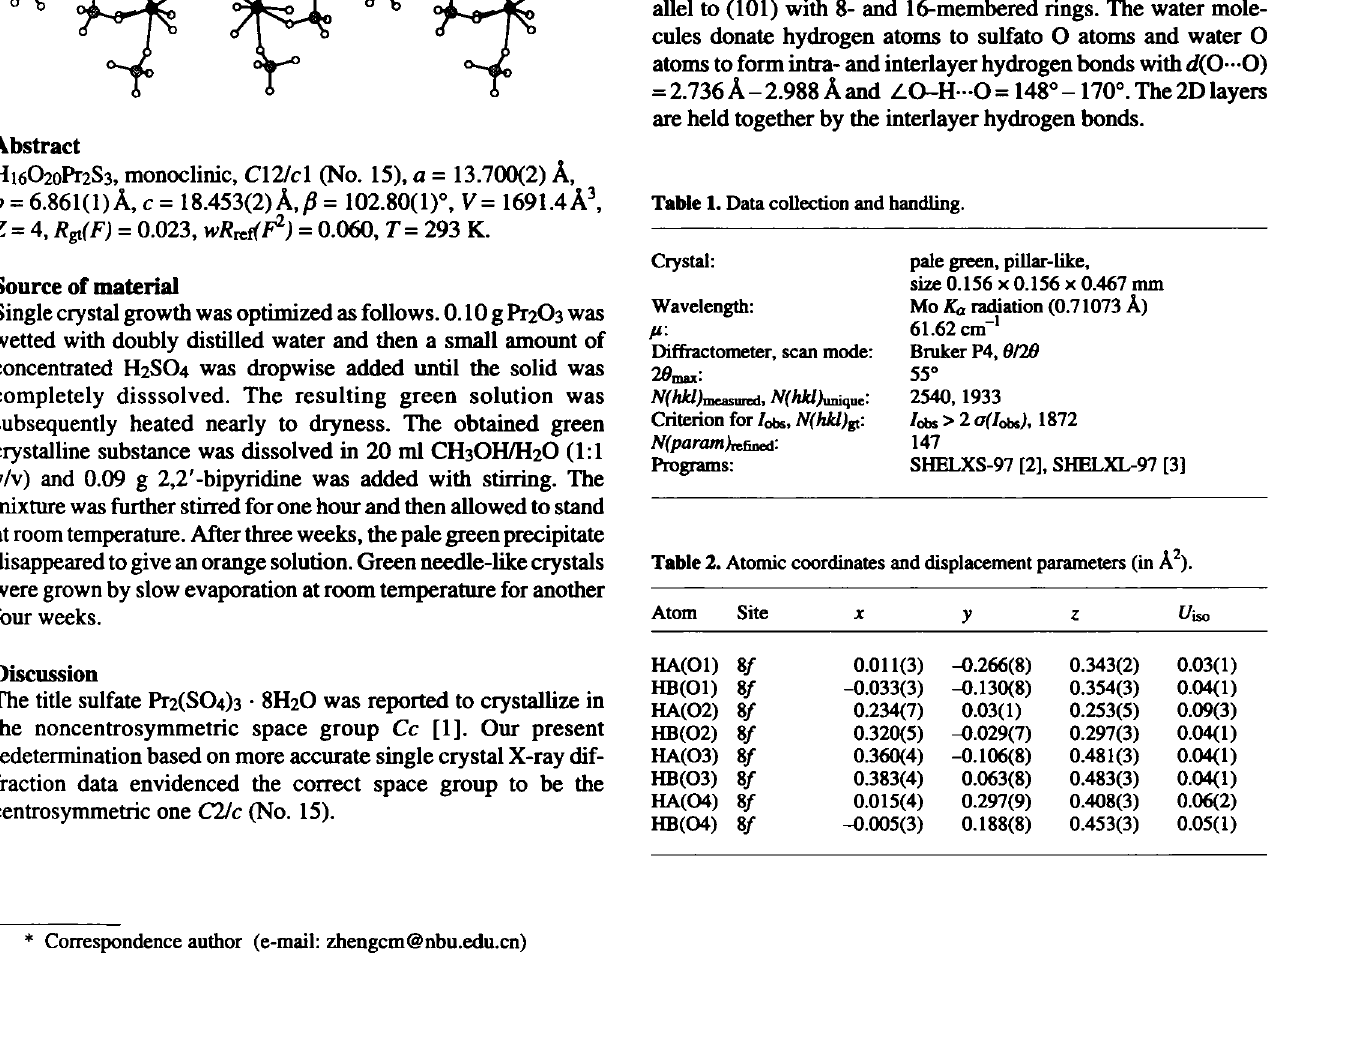
Table 1. Data collection and handling.